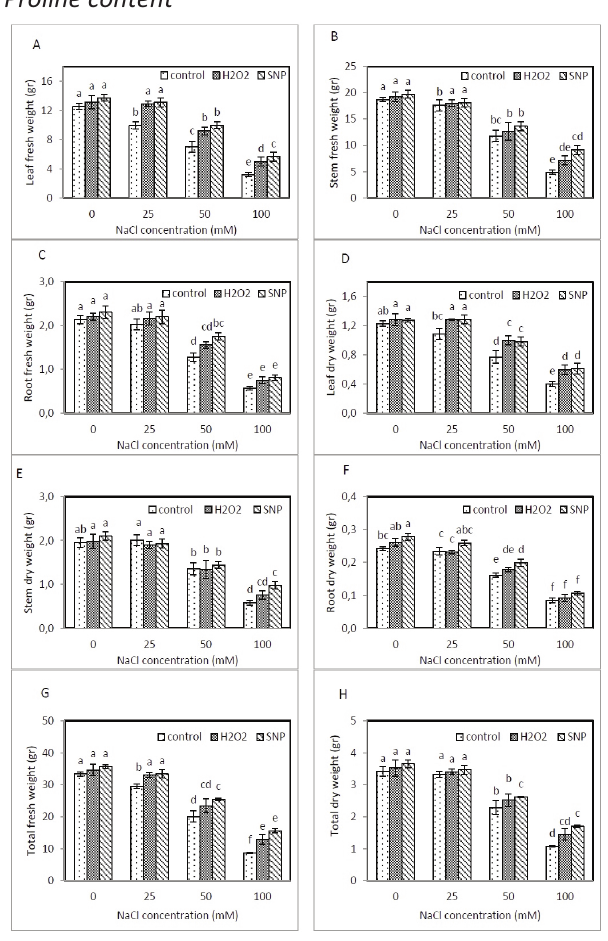
Fig. 1 - Effect of salt treatment and application of exogenous O and SNP on growth parameter of tomato plants. H 2 2 Leaf fresh weight (A), stem fresh weight (B), root fresh weight (C), leaf dry weight (D), stem dry weight (E), root dry-weight (F), total fresh weight (G), and total dry wei- ght (H). Data shown are the mean (±SE) of three inde- pendent experiments. Significant differences among treatments were determined by Tukey's Test (P<0.05).